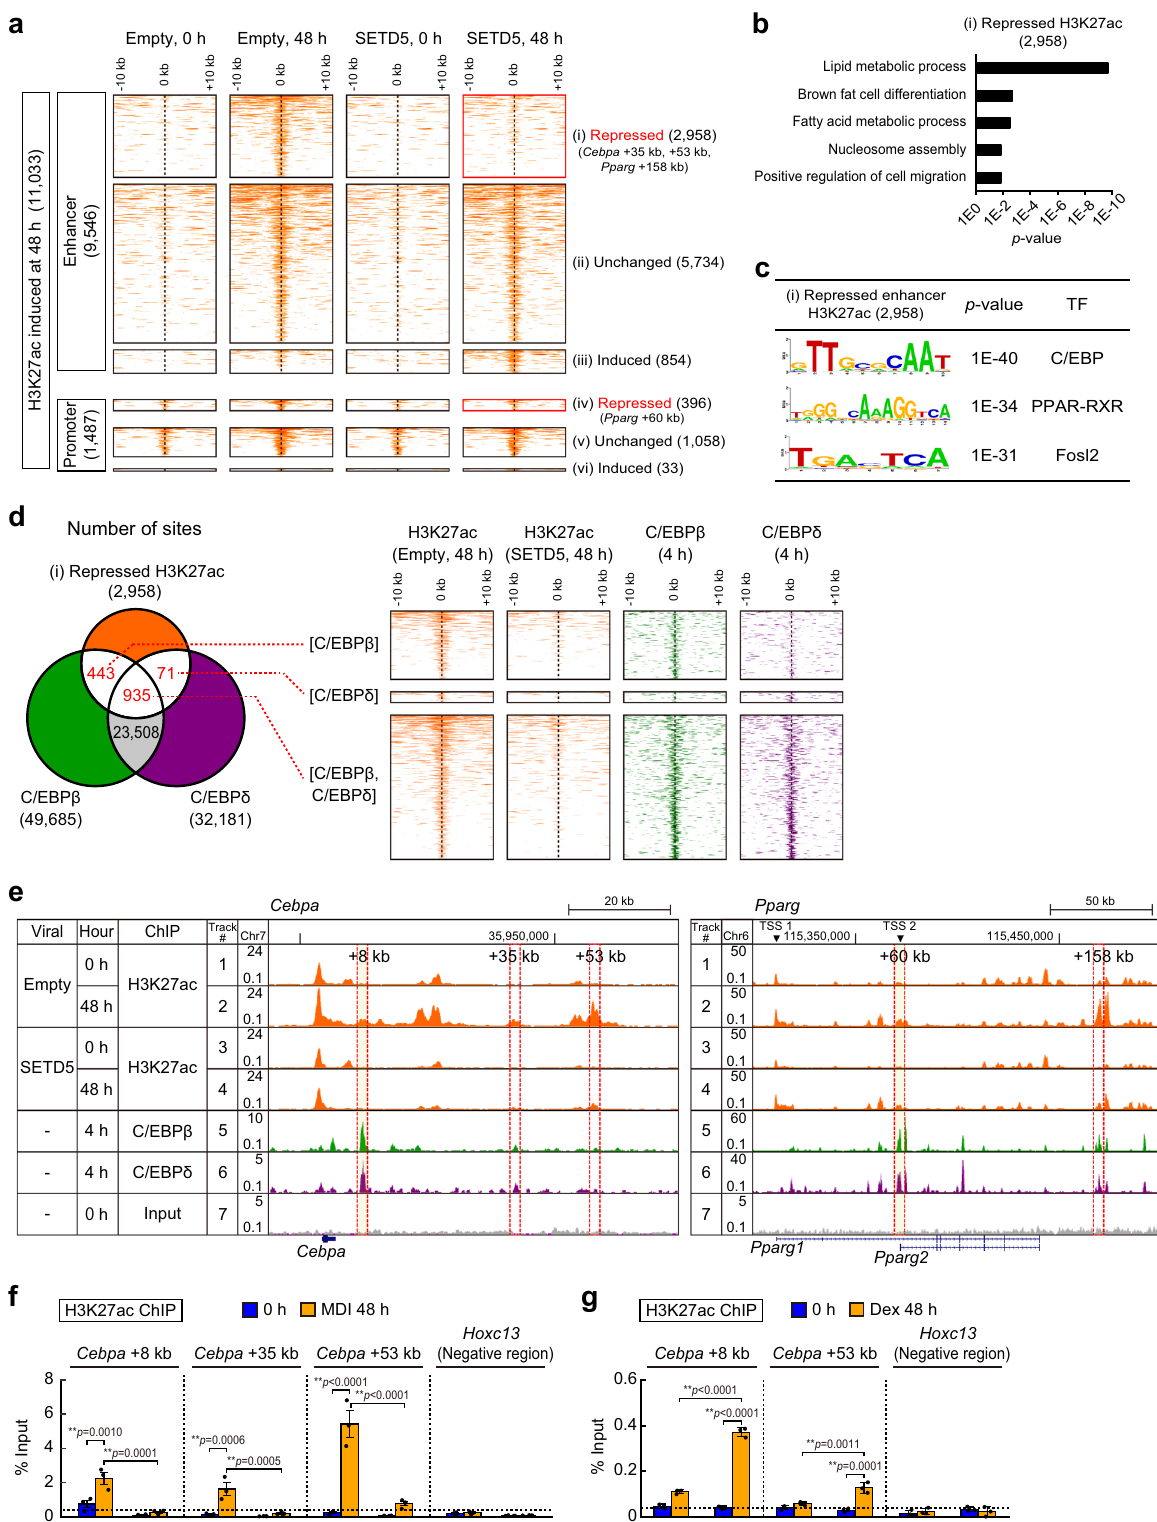
H3K27 acetylation at C/EBP binding site enhancers for Cebpa and Pparg genes. Transient stabilization and APC/C-mediated proteasomal degradation of SETD5 during early adipogenesis . Because